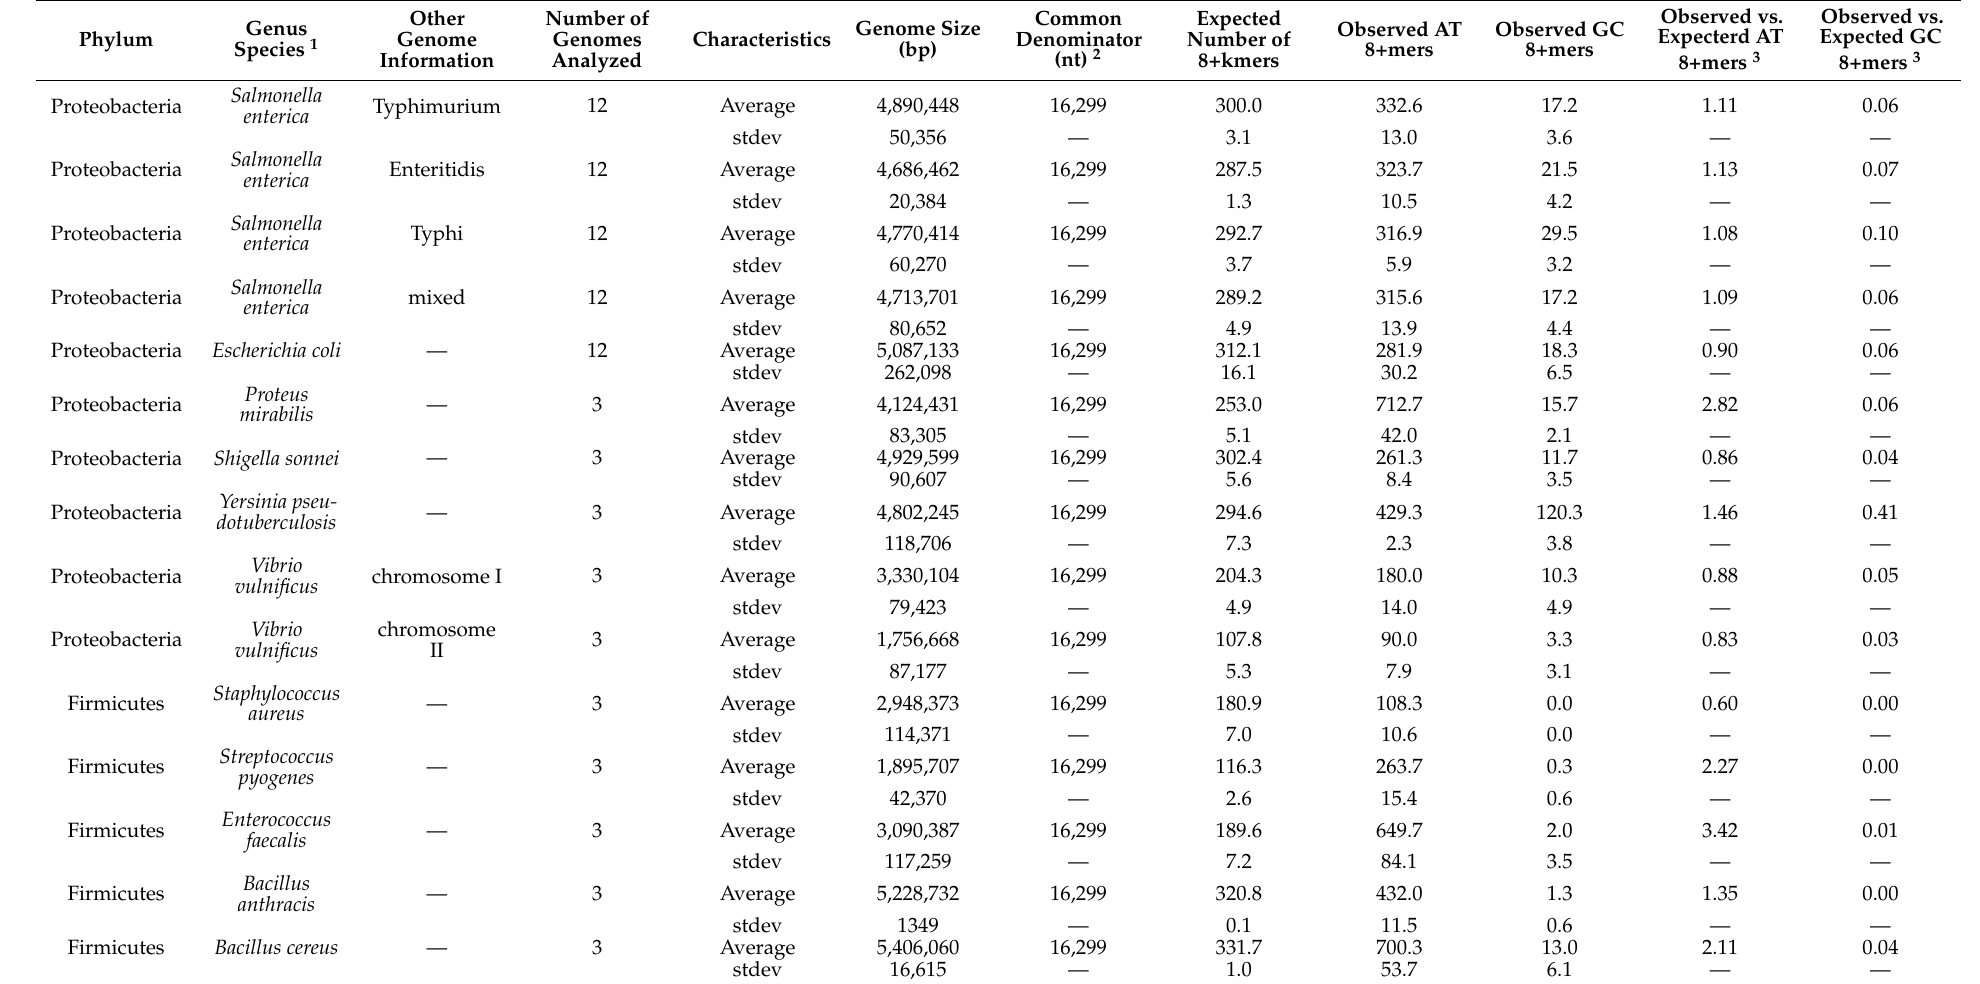
Table 1. Expected versus observed occurrence of homopolymer strings of 8 and more nucleotides in genomes of